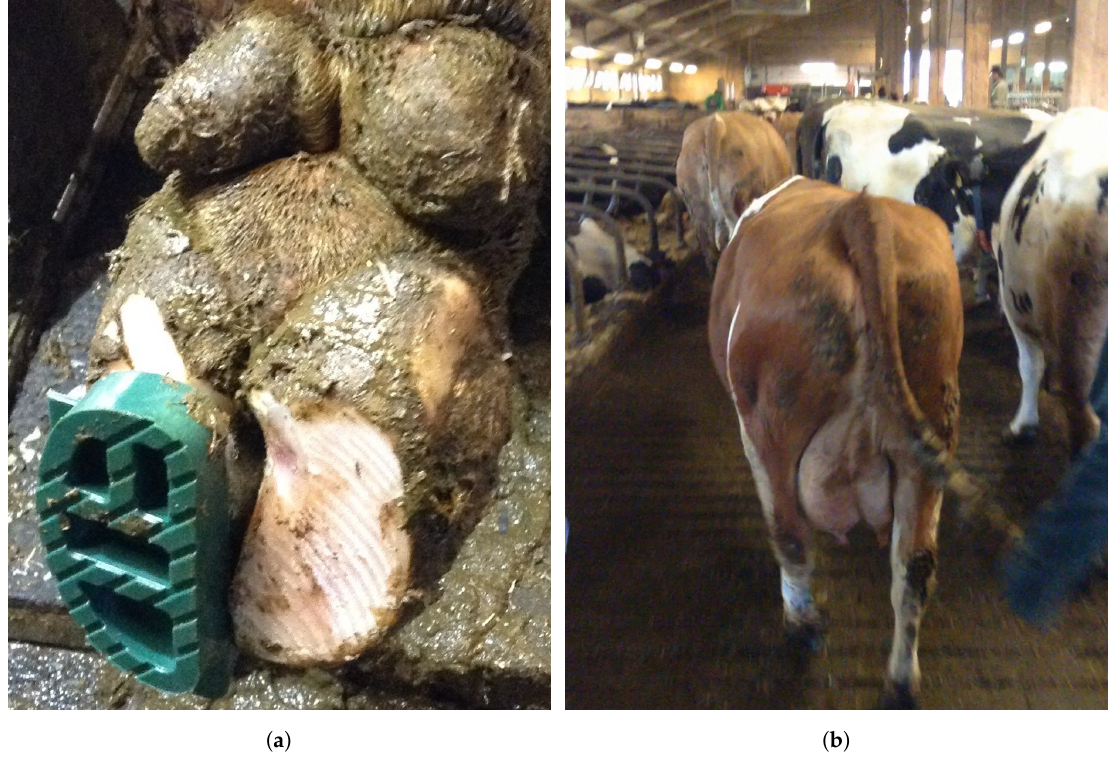
Figure 2. Plastic block attached to the outer claw of a cow’s left hind hoof taken from our previous work [4] ( a ) and member of our team walking behind a cow in the indoor stable of the Ludwig Maximilian University (LMU) Munich during the data collection ( b